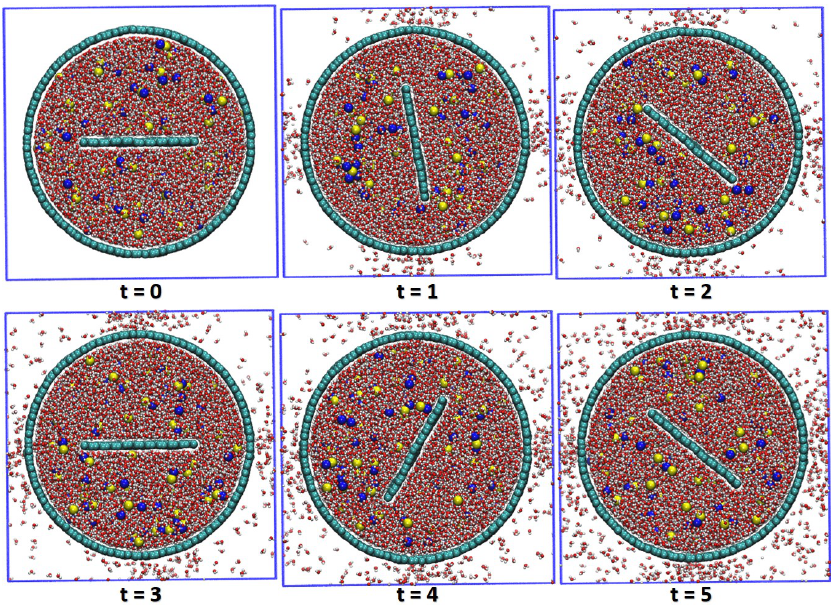
Figure 3. Snapshots of Model II over six simulation times, in unit nano-second. Na + and Cl − ions are in blue and yellow color, other molecules are H 2 O with oxygen atom in red